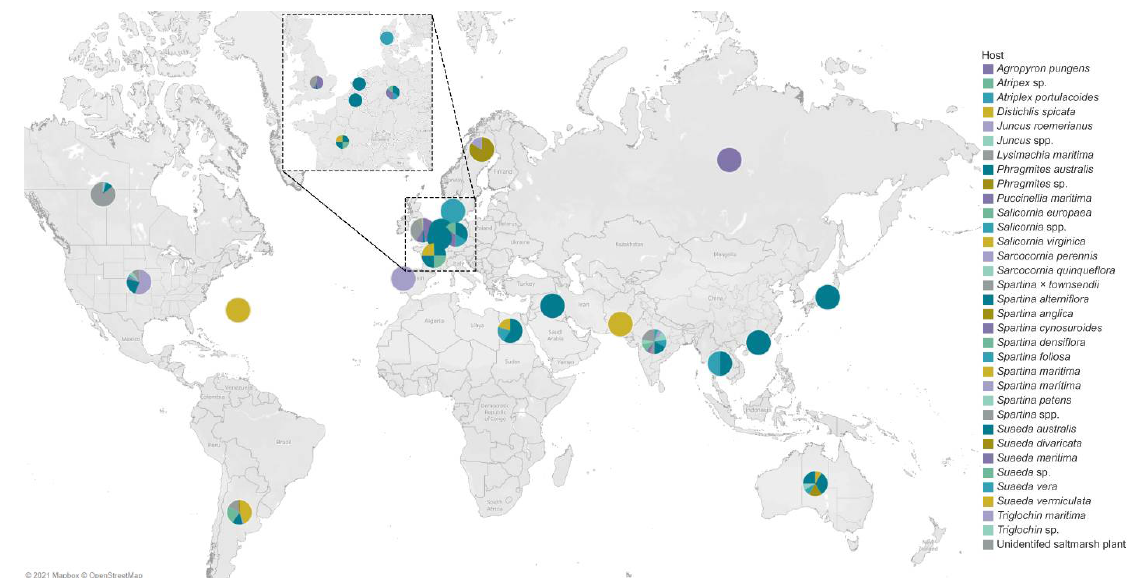
Figure 15. Map of countries showing the global distribution of fungal diversity studies in halophytes. The different color of each pie chart represents the hosts, and the angle measured the number of their fungal associates.